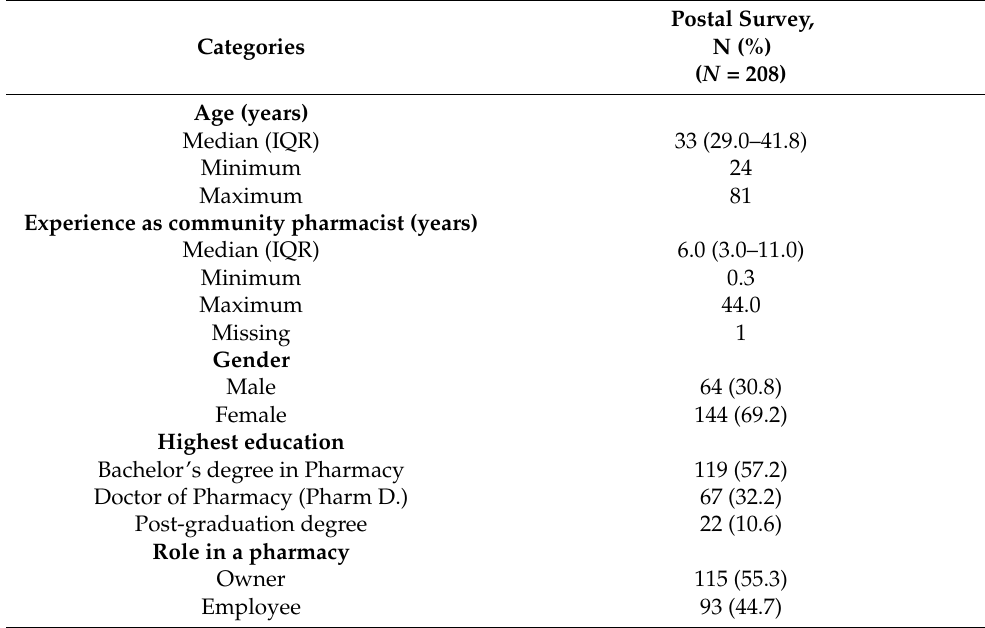
Table 1. Demographics of